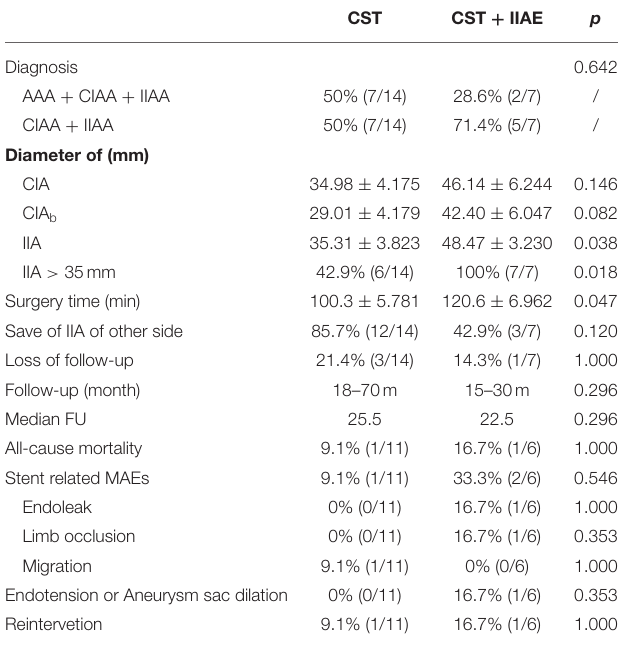
TABLE 4 | Results of different IIAA treatment strategies in CST